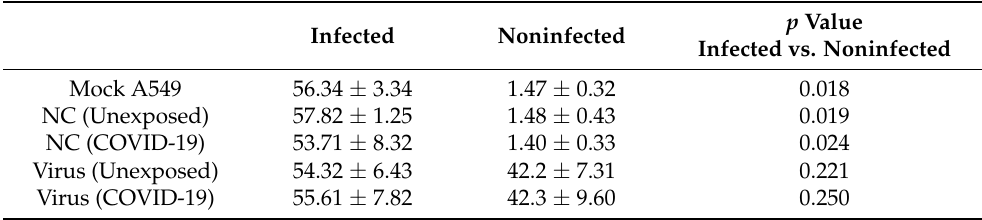
Table 4. Frequency of A549 cells (%) expressing